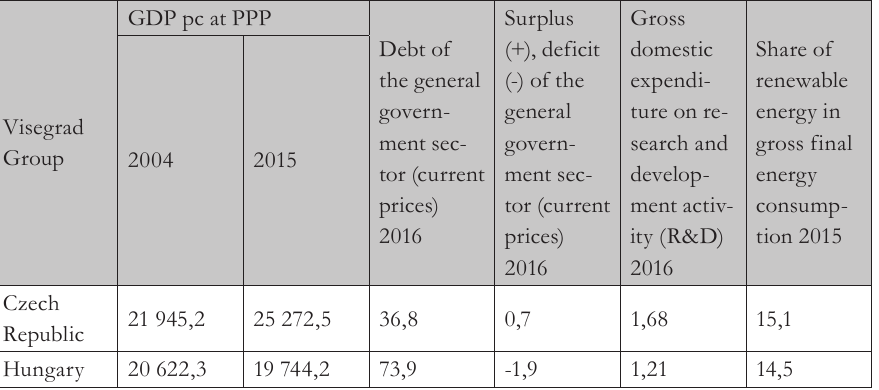
Tab. 3 – Selected indicators – economic situation in Visegrad countries. Source: Statistical Of- fice Poland, 2018, www.stat.gov.pl (access: